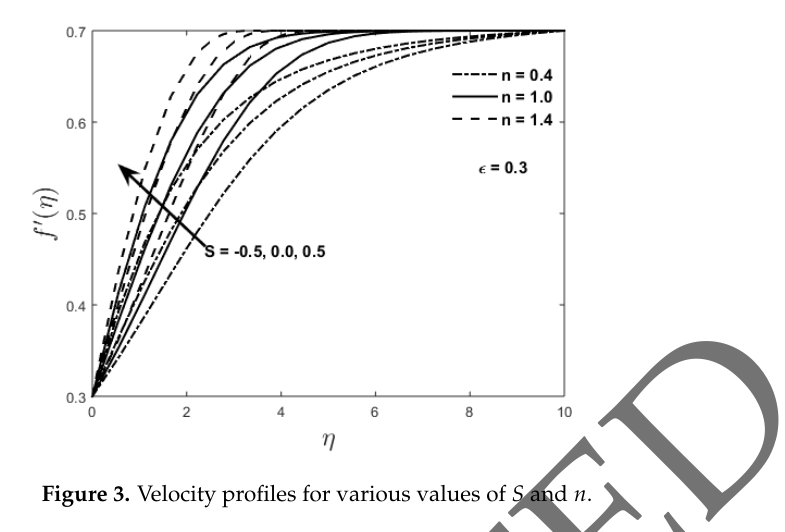
Figure 3. Velocity profiles for various values of S and n .